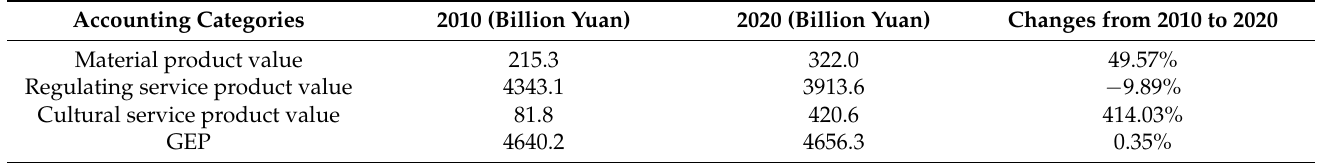
Table 4. The value and change of ecological products in Jiangxi Province (2010–2020).